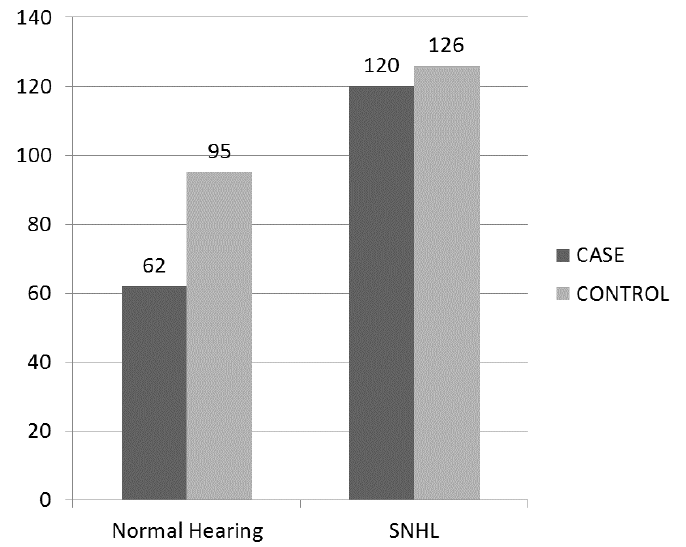
Figure 3. Incidence of sensorineural hearing loss among cases and controls (182 cases and 221